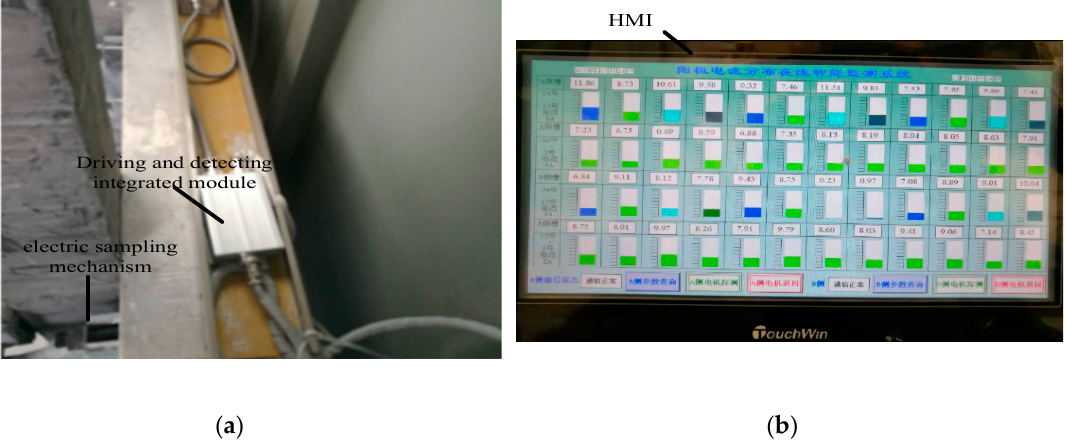
Figure 8. On-line anode current distribution detect device: ( a ) multichannel acquisition module; ( b ) human machine interface (HMI).